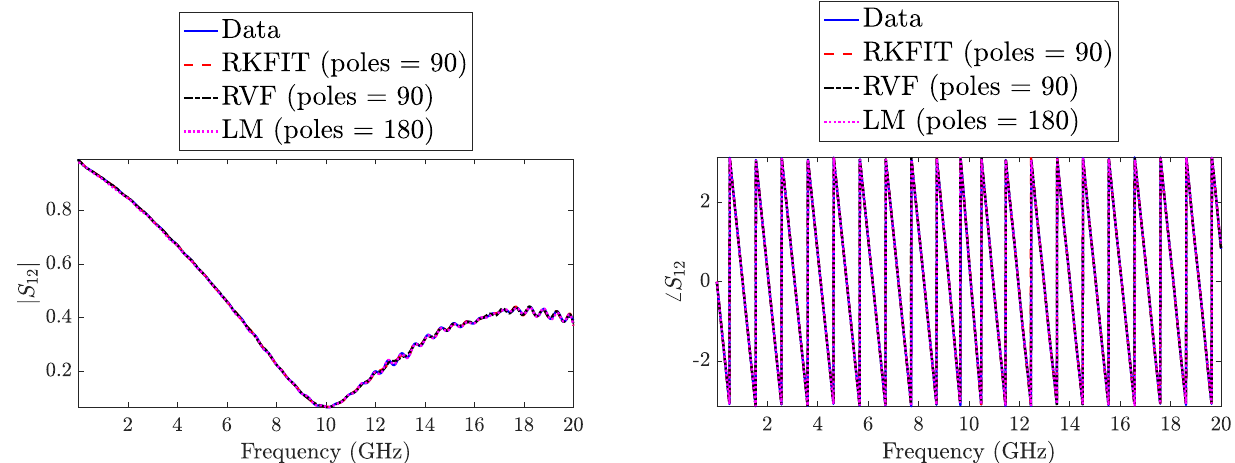
Figure 3. Comparison ofRKFIT with RVF and LM models with given data for S 12 of Section 3.1.